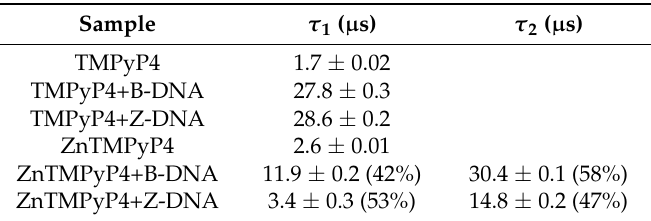
Table 1. Triplet decay lifetimes of TMPyP4 and ZnTMPyP4 in air-saturated solution and in their complexes with B-DNA and Z-DNA. Pre-exponential factors of the two lifetime components in the biexponential fitting I = I 0 + A 1 e − t / τ 1 + A 2 e − t / τ 2 yield the respective percentages of two binding modes (values shown in